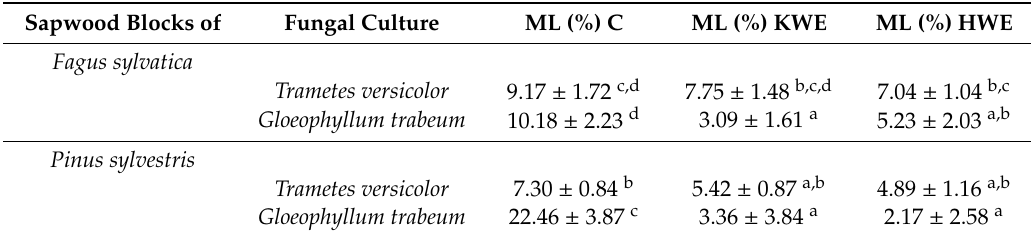
Table 4. Mass loss (ML, %) of KWE and HWE-impregnated beech and Scots pine sapwood exposed to white-rot ( Trametes versicolor ) and brown-rot fungi ( Gloeophyllum trabeum ) for 12 weeks. Sapwood Blocks of